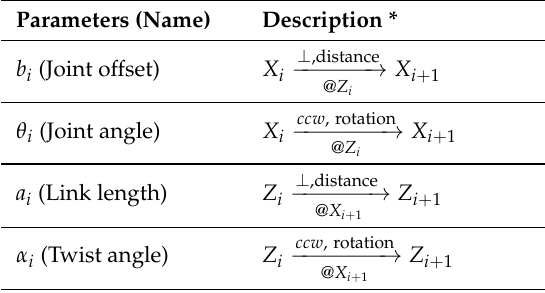
Table A1. Notations and descriptions of the DH parameters